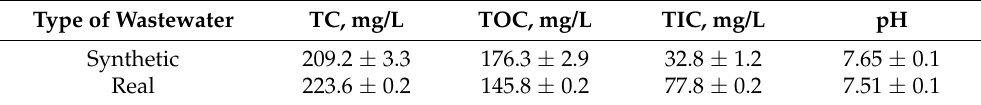
Table 5. Characteristics of municipal and synthetic wastewater